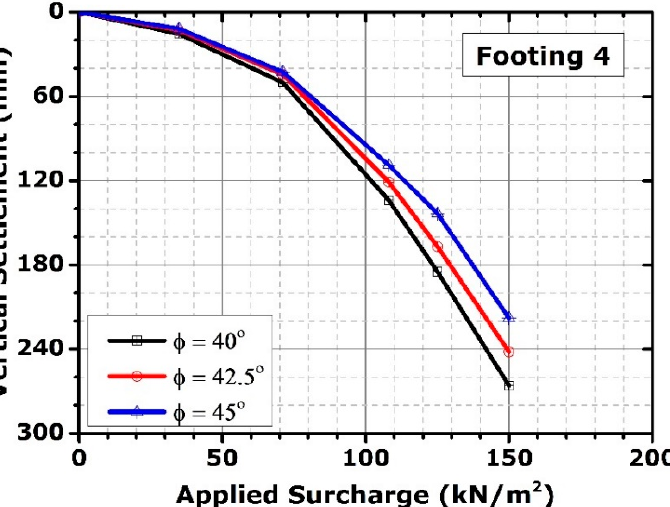
Figure 18. Influence of column strength upon footing settlement in drained conditions–Footing